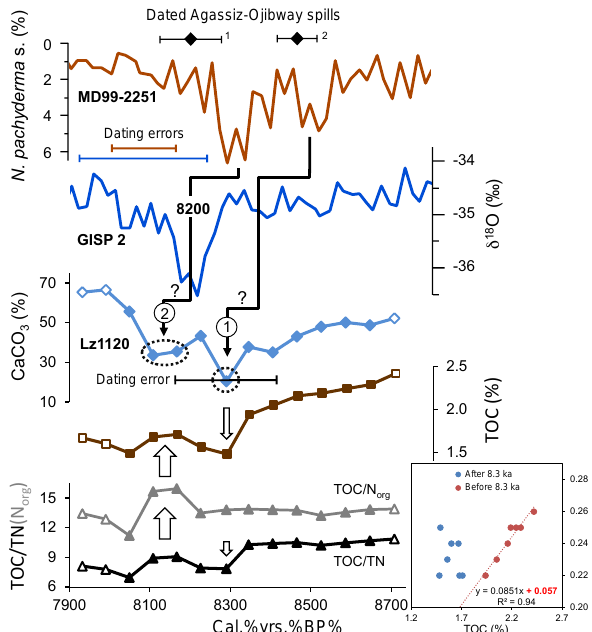
Figure 2. Records of carbonate (CaCO 3 ) , total organic carbon (TOC) and the organic carbon to total nitrogen ratio (TOC / TN) of core Lz1120 compared to proxy data from the North Atlantic. Phases of increased percentages of N. pachyderma s. in MD99- 2251 indicate at least two southward shifts of colder surface wa- ters (Ellison et al., 2006) while the excursion in the δ 18 O record of Greenland ice cores (GISP), which first defined the 8.2ka event, indicates a drop in atmospheric temperature over the Greenland Ice Sheet (Grootes et al., 1993). The dashed circles mark those samples that are discussed as low-carbonate samples in carbonate minima 1 and 2 and are possibly corresponding to the climatic deteriorations occurring over the course of the 8.2ka event caused by at least two catastrophic freshwater spills into the North Atlantic ( 1 Roy et al., 2011; 2 Lajeunesse and St-Onge, 2008). Closed symbols mark sam- ples analysed for their lipid biomarker composition. White arrows highlight different fluxes of organic carbon and total nitrogen during the carbonate minima. Inset: TOC vs. TN for samples from before (red) and after (blue)